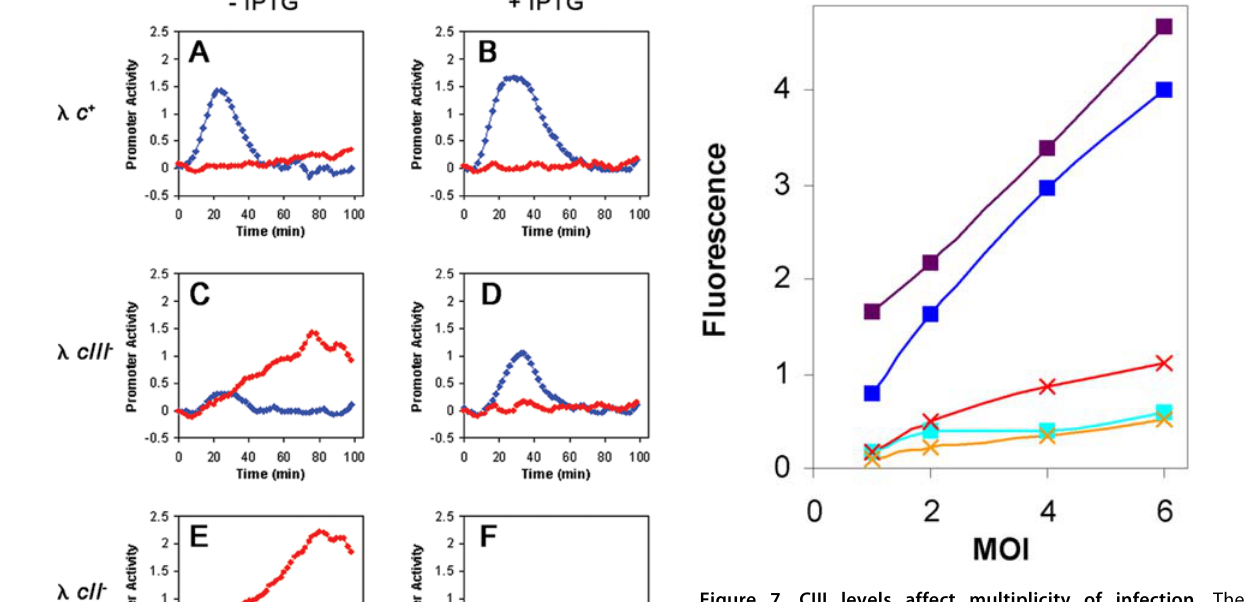
Figure 7. CIII levels affect multiplicity of infection. The total fluorescences obtain from the pE-GFP plasmid, 80 minutes after infection were plotted against the MOI of each experiment. l cIII 2 infections of bacteria carrying the pCTCIII plasmid were followed in the absence (light blue squares) or presence of 0.1 mM IPTG (blue squares) or of 0.2 mM IPTG (purple squares). l c + (red 6 symbol) and l cIII 2 (orange 6 symbol) infections of bacteria without the pCTCIII plasmid are shown as reference. Table 1. The dominant negative effect of CIII mutants as